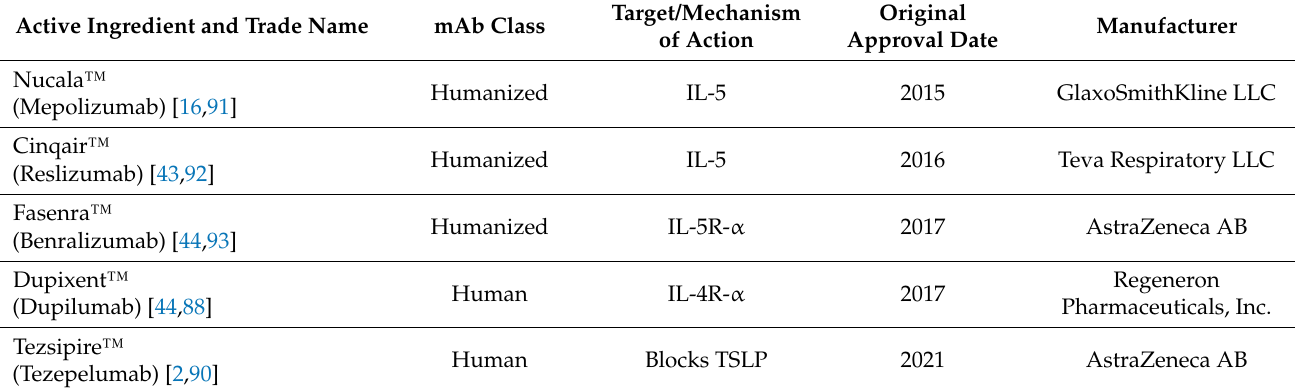
Table 8. Monoclonal antibodies for asthma and severe asthma approved by the Food and Drug Administration from 2015 to